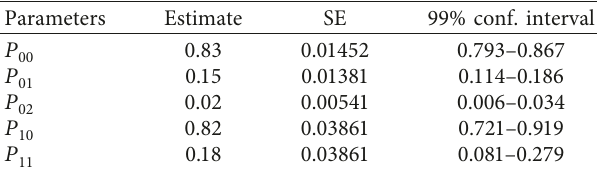
Table 6: ML estimates of transition probabilities for TB.